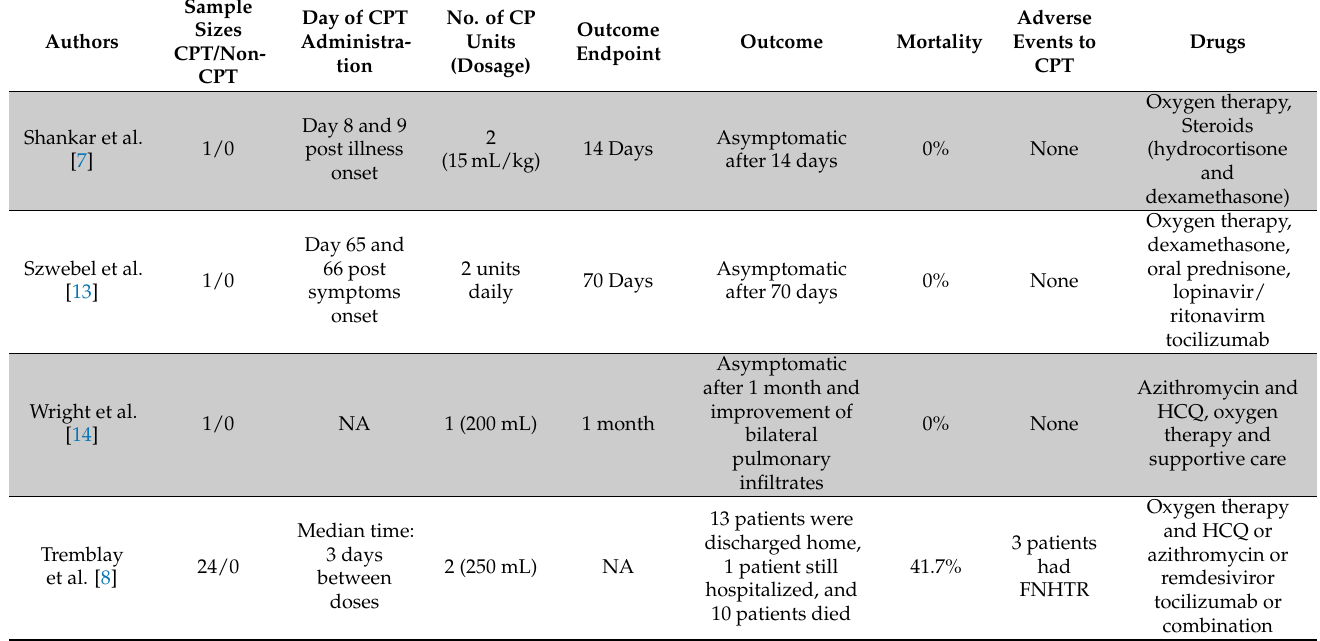
Table 3. Summary of clinical outcomes from selected